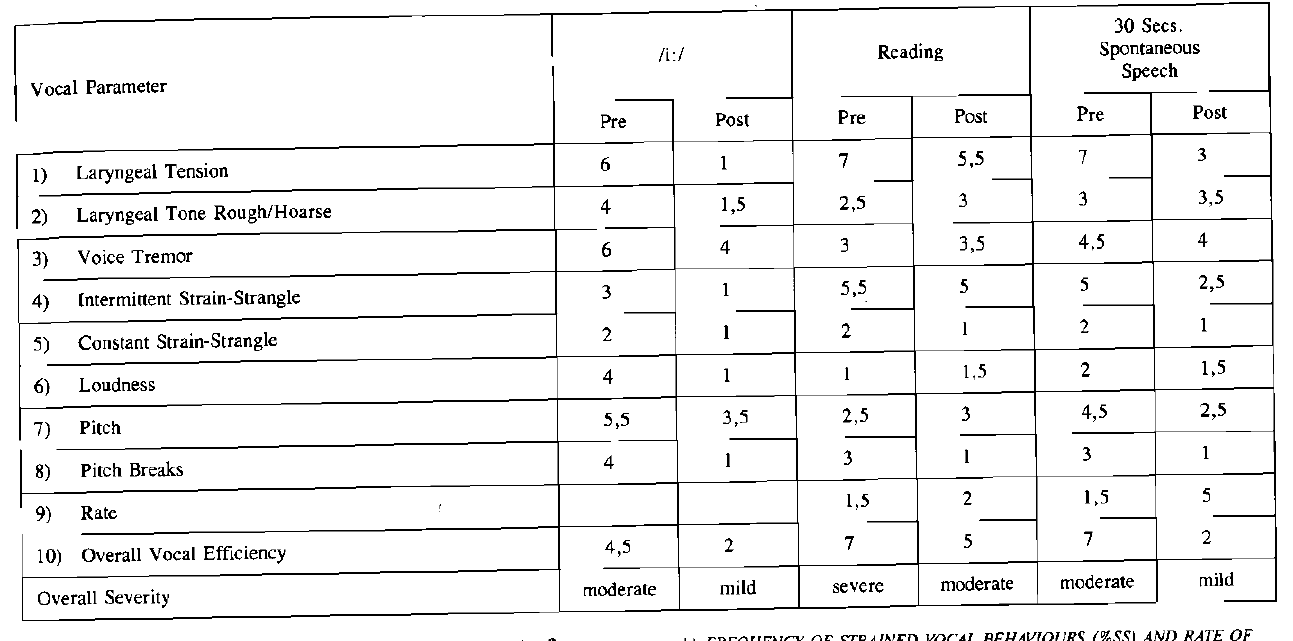
Table 2 Pre- and post-therapeutic frequency count of strained syllables (%SS); total number of syllables and rate of speech in SPM for reading and spon- taneous speech.